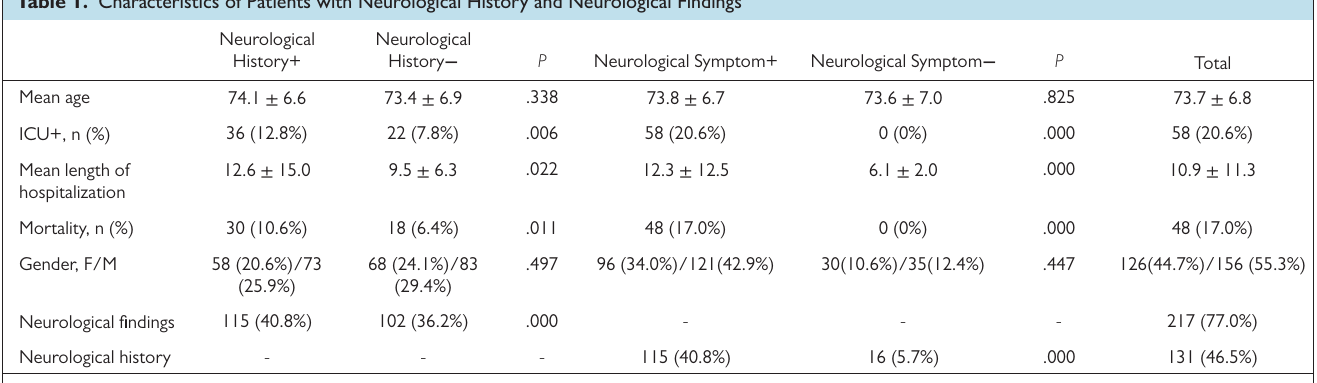
Table 1. Characteristics of Patients with Neurological History and Neurological